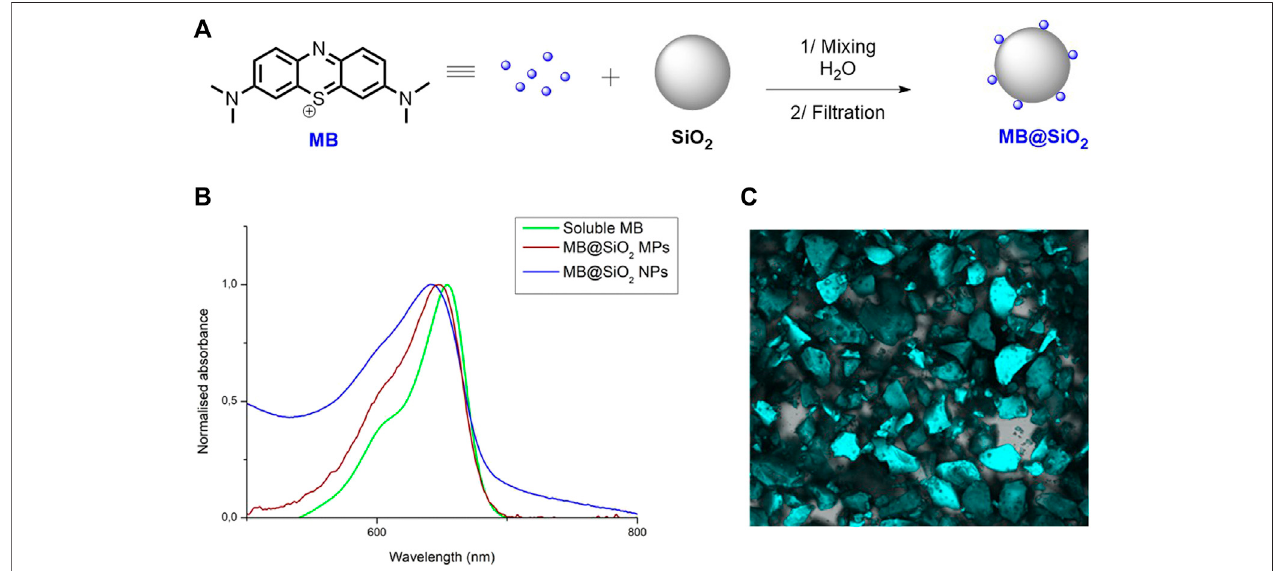
FIGURE1|(A) StructureofMBandprocessfortheheterogenizationofMBonSiO 2 ; (B) AbsorptionspectraofMB(green)anddispersedMB@SiO 2 MPs(blue)and MB@SiO 2 NPs (red) in CH 3 CN; (C) Fluorescence microscopy snapshot of MB@SiO 2 MPs treated with pure SiO 2 MPs in CH 3 CN.